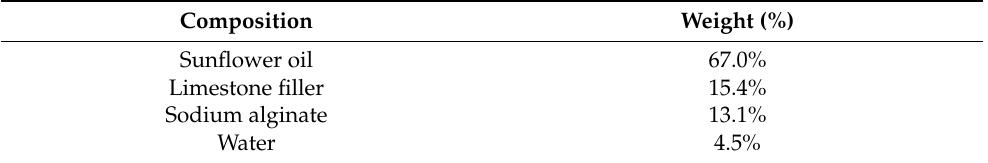
Figure 1. Diagram of the upscaled encapsulation procedure. Table 1. Polymeric capsules’ composition.